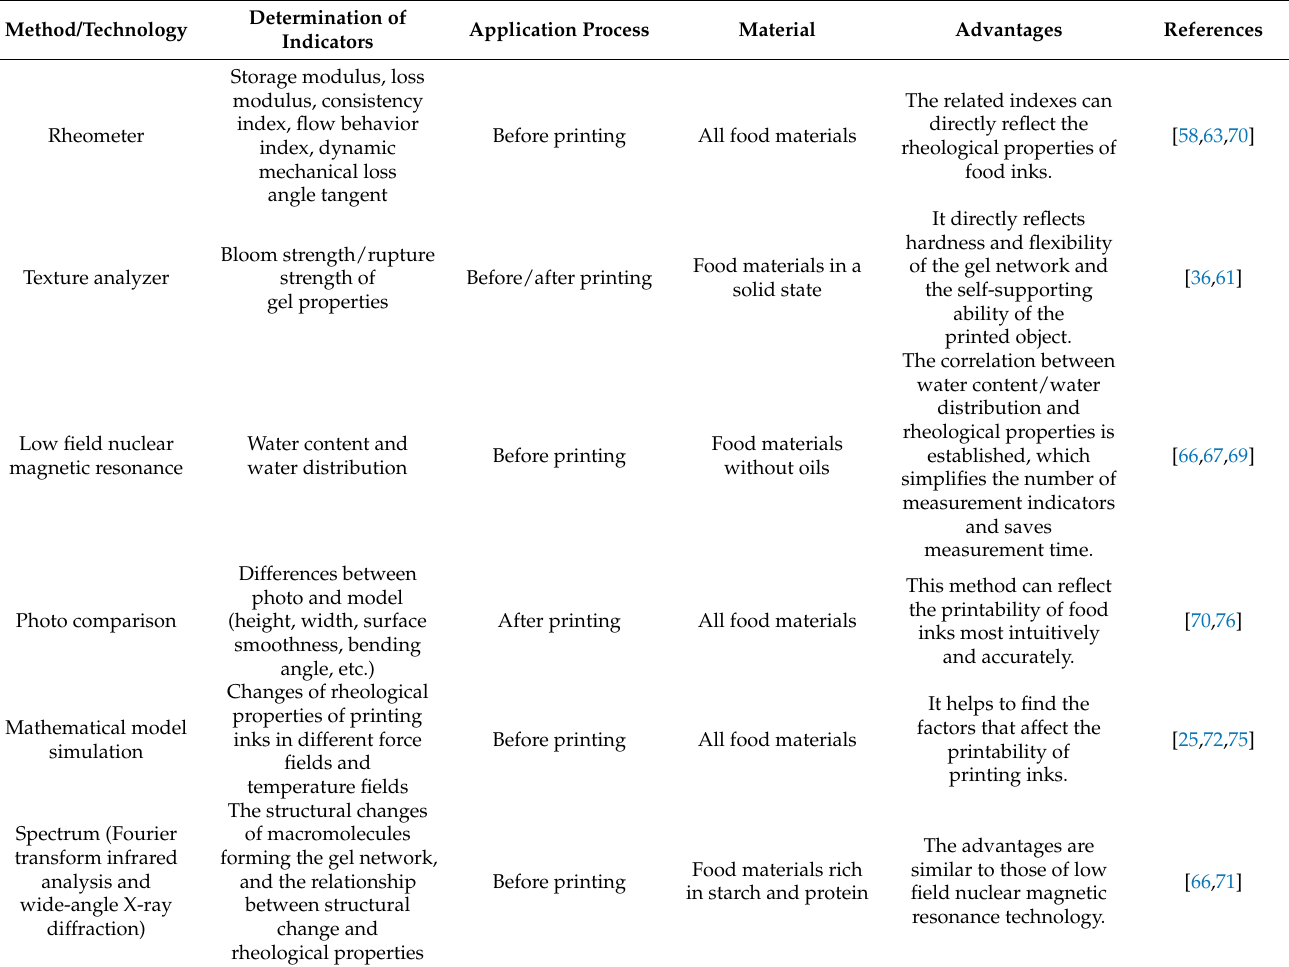
Table 2. Evaluation methods/techniques for printability of food